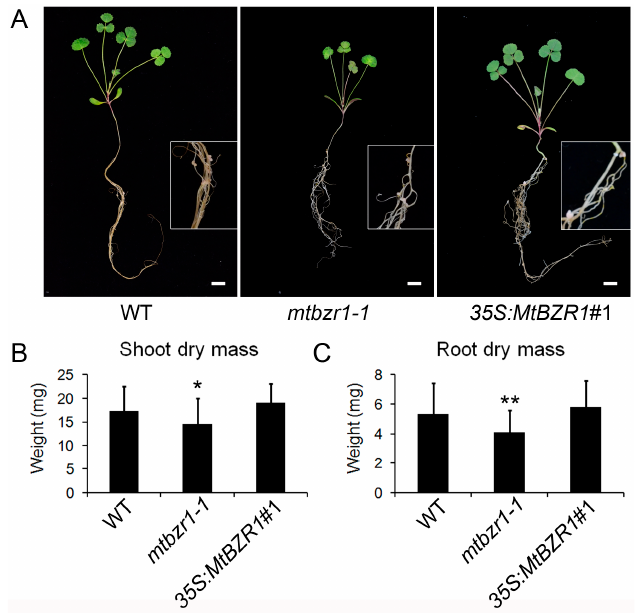
Figure 3. Reduced dry mass in mtbzr1-1 in nodulation. ( A ) Photos of one-month-old wild-type (WT),